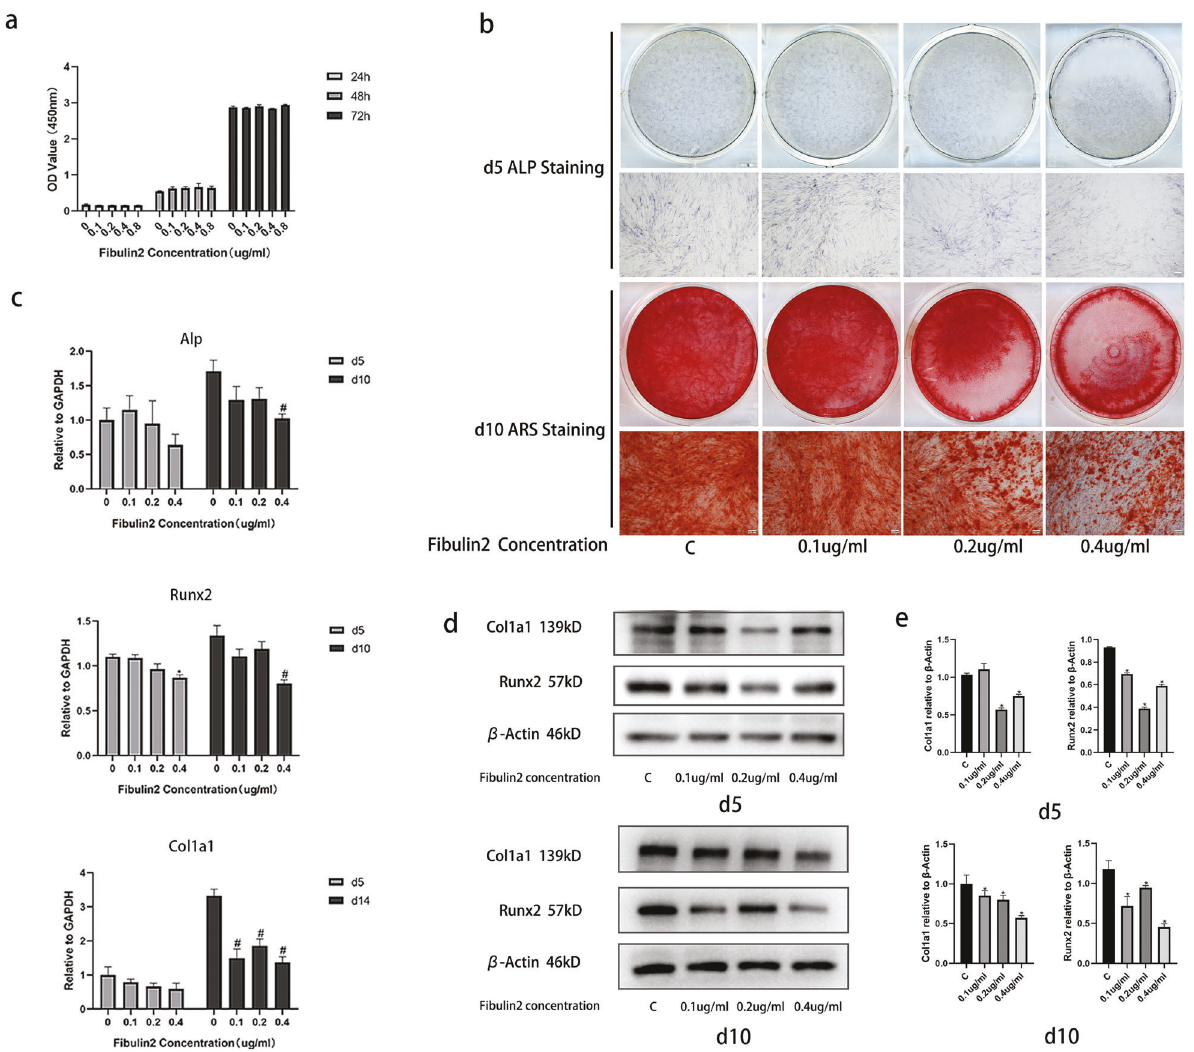
Fig. 4 Fibulin2 negatively regulates the osteogenic differentiation of BMSCs in vitro. a Cell Counting Kit-8 (CCK-8) data revealed no differences in the optical density (OD) value of the BMSCs treated with different concentrations of Fibulin2 at 24, 48, or 72 h. b Alkaline phosphatase (ALP) staining on Day 5 and alizarin red staining (ARS) on Day 10 were performed after the BMSCs were stimulated with different concentrations of Fibulin2 to induce osteogenic differentiation. Reduced Alp activity was found at 5 days, and fewer calcium nodules were identi fi ed 10 days after stimulation with Fibulin2. c The expression of Alp, Runx2 and Col1a1 in BMSCs was detected by RT-qPCR. (*the Fibulin2 group vs. the control group, P < 0.05 on Day 5; #the Fibulin2 group vs. the control group, P < 0.05 on Day 10; n = 3). d The expression of Col1a1 and Runx2 in BMSCs as detected by western blotting (WB). e Quanti fi cation of WB data (*the Fibulin2 group vs. the control group, P < 0.05; n =